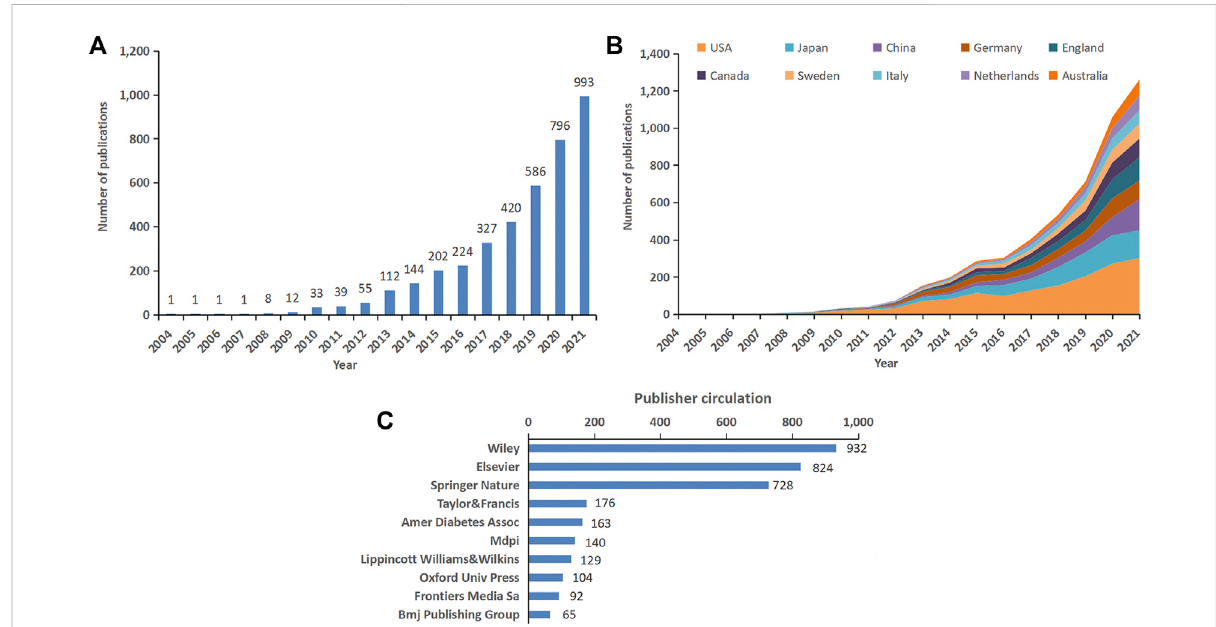
FIGURE 2 Global publication trend and country or region analysis for SGLT2 inhibitor research. (A) Annual worldwide publication output. (B) Growth trendsinpublicationoutputfromthetop10productivecountries. (C) Top10publishersaccordingtotheircontributiontothetotalnumberofarticles in SGLT2 inhibitor